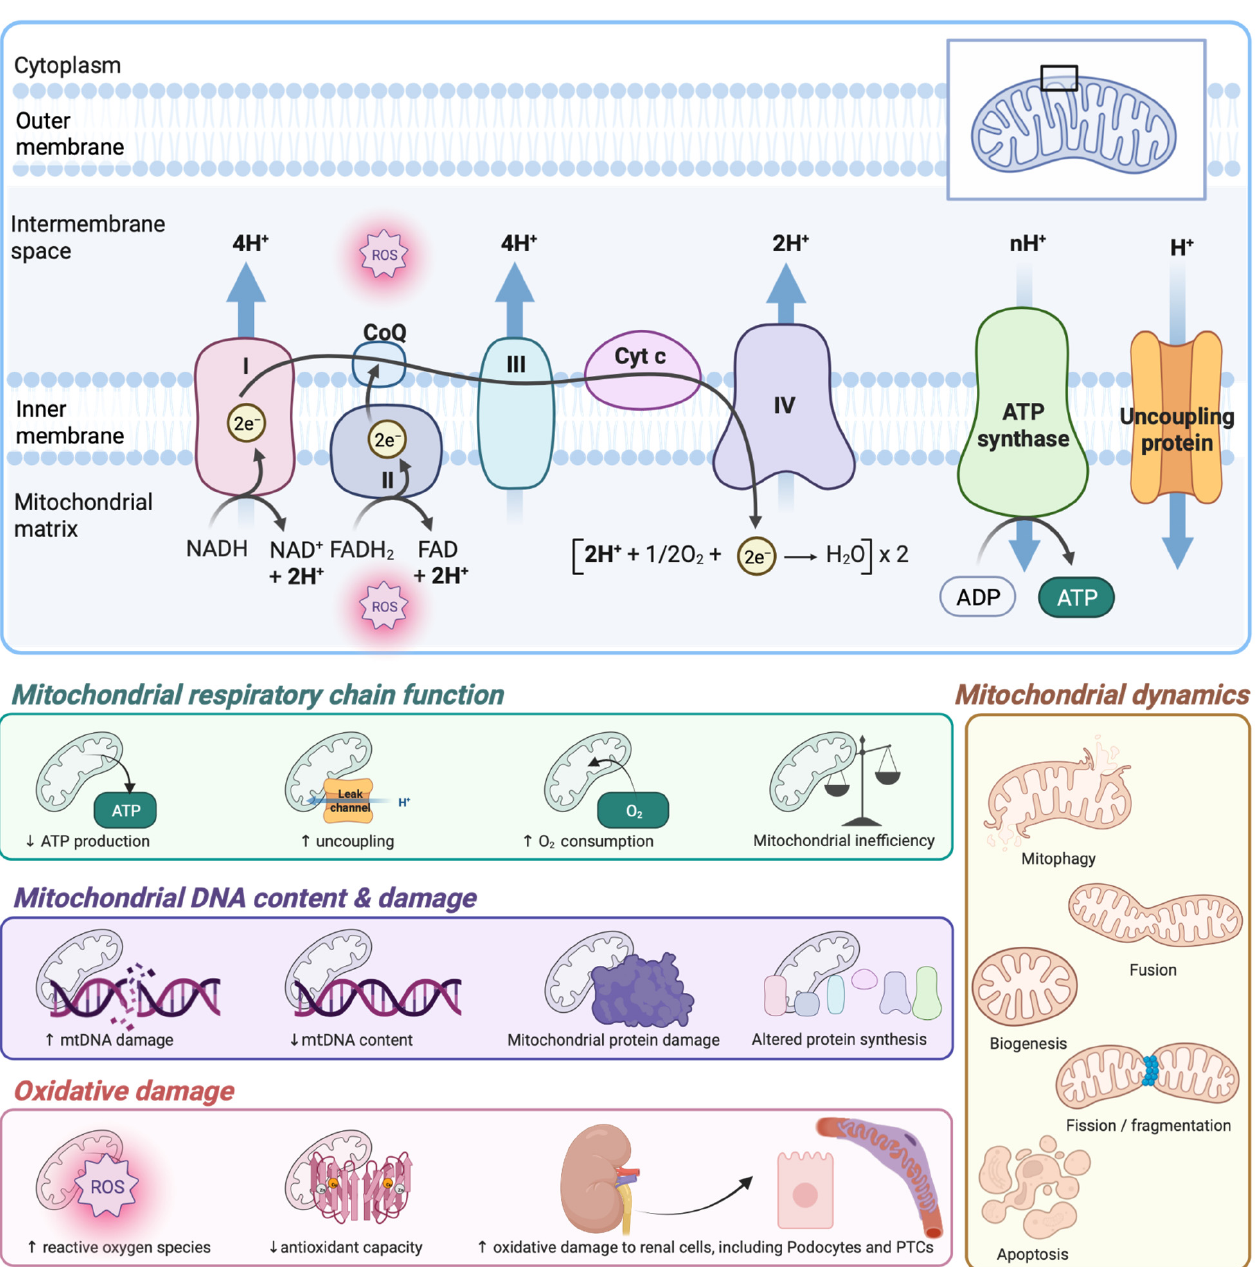
Figure 1. Potential pathways of mitochondrial dysfunction contributing to and/or exacerbating disturbances in renal oxygenation and energetics in diabetes. ADP, adenosine diphosphate; ATP, adenosine triphosphate; CoQ, coenzyme Q; Cyt C, cytochrome C; e − , electrons; FAD, flavin adenine dinucleotide (oxidised); FADH 2 , flavin adenine dinucleotide (hydroquinone); H + , hydrogen ions; H 2 O, water; mtDNA, mitochondrial deoxyribonucleic acid; NAD + , nicotinamide adenine dinucleotide (oxidised); NADH, nicotinamide adenine dinucleotide (reduced); O 2 , oxygen; PTCs, proximal tubule cells; ROS, reactive oxygen species. Image created with BioRender.com.